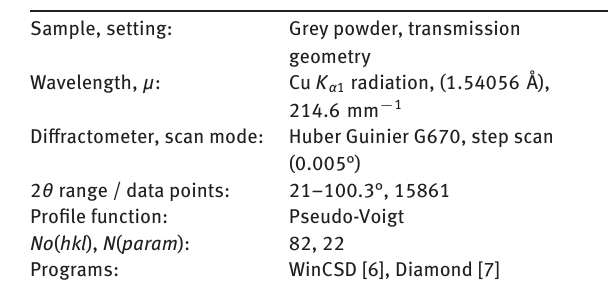
Table 1: Data collection and handling.